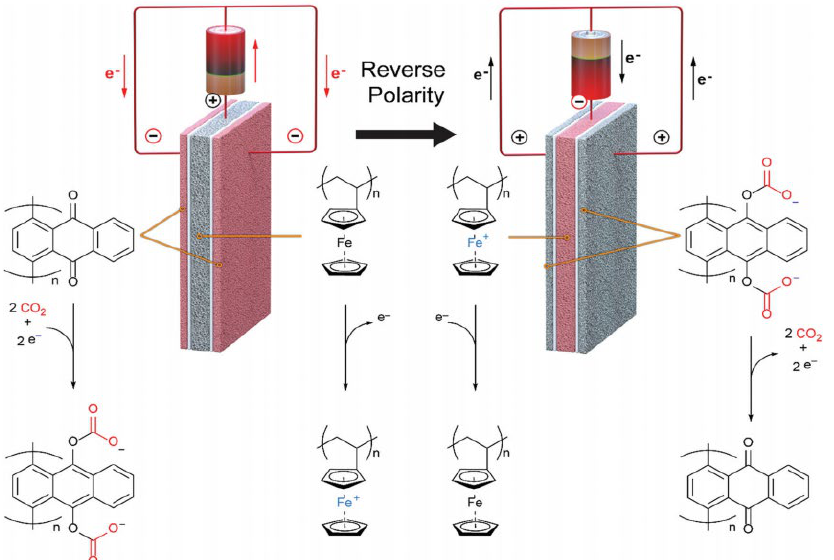
Figure 9. Schematic of a single electro-swing adsorption electrochemical. Reproduced under the Creative Commons attribution noncommercial 3.0 unported licence [120] .